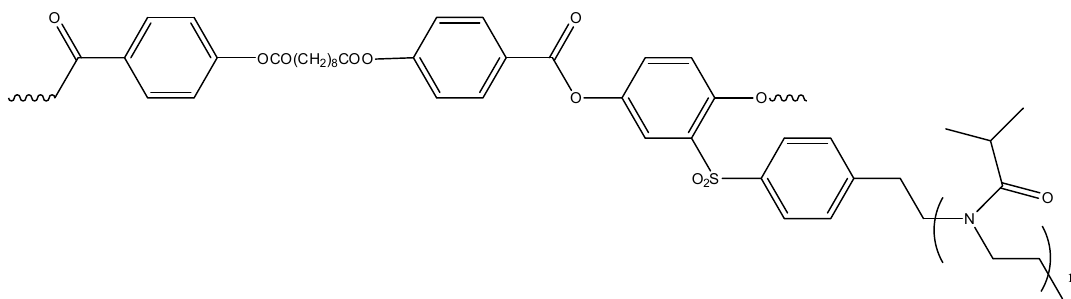
Figure 1. Structural formula of the aromatic polyester (APE)-g-poly-(2-isopropyl-2-oxazoline) (PiPrOx) graft copolymer.